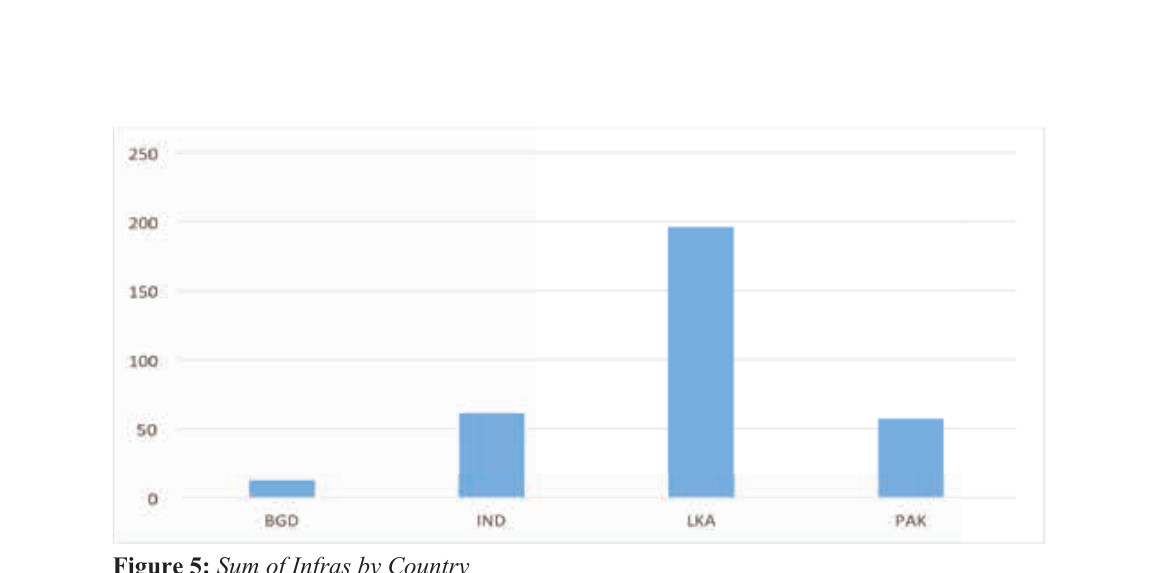
Figure 5: Sum of Infras by Country